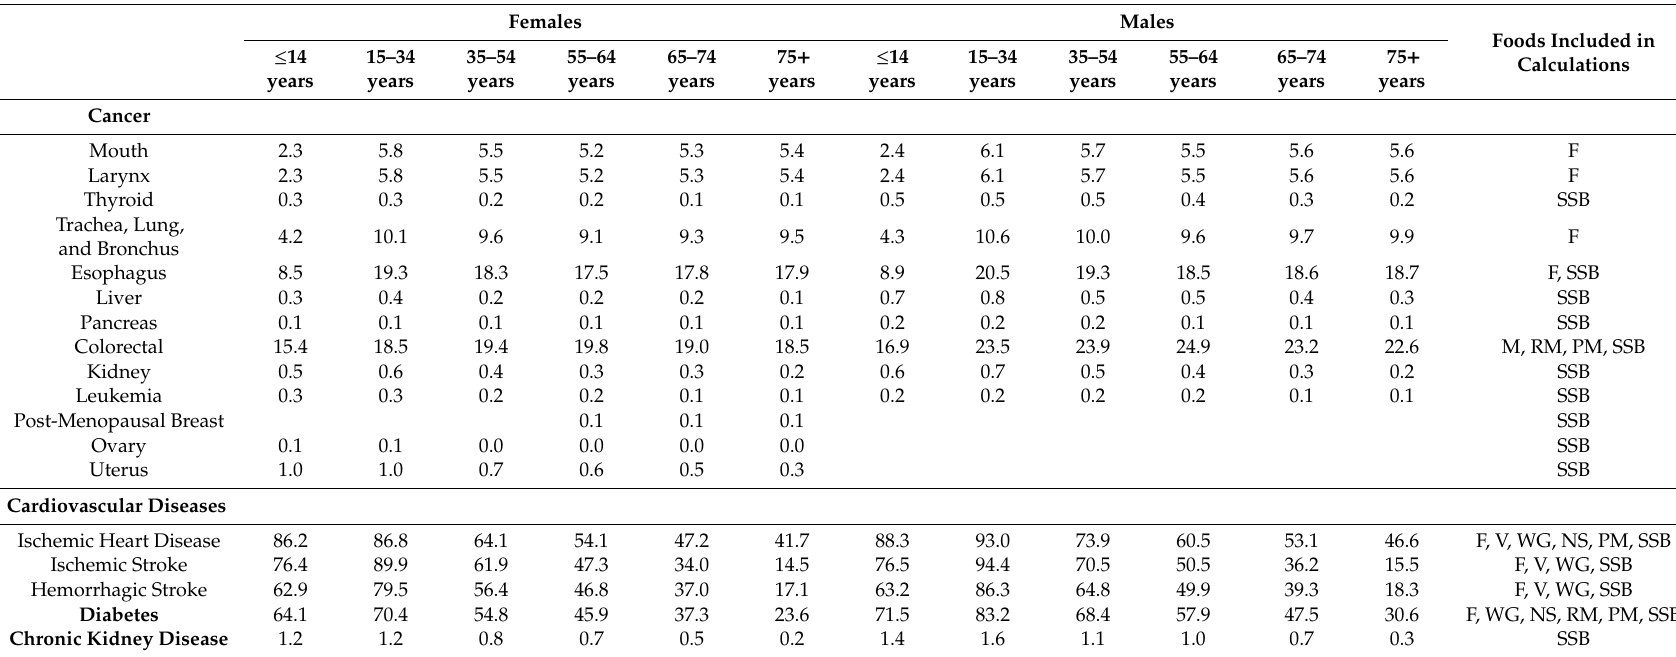
Table 3. Combined population attributable fractions for foods with established food recommendations presented by age, sex, and chronic